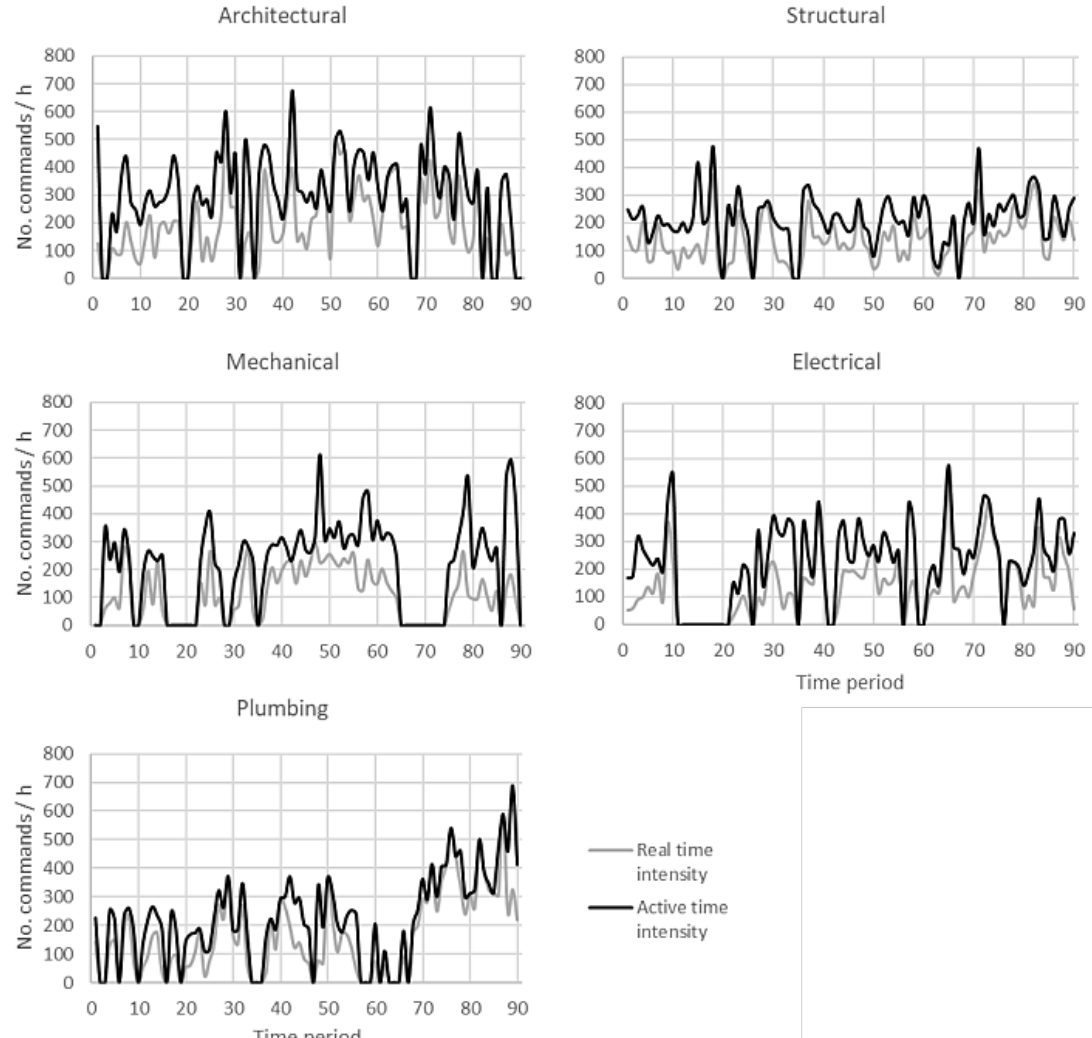
Figure 5. Real time and active time work intensities for each designer.